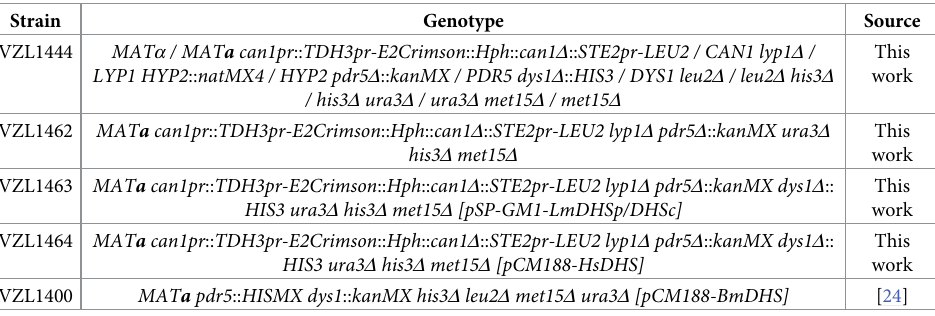
Table 2. Saccharomyces cerevisiae strains used in this